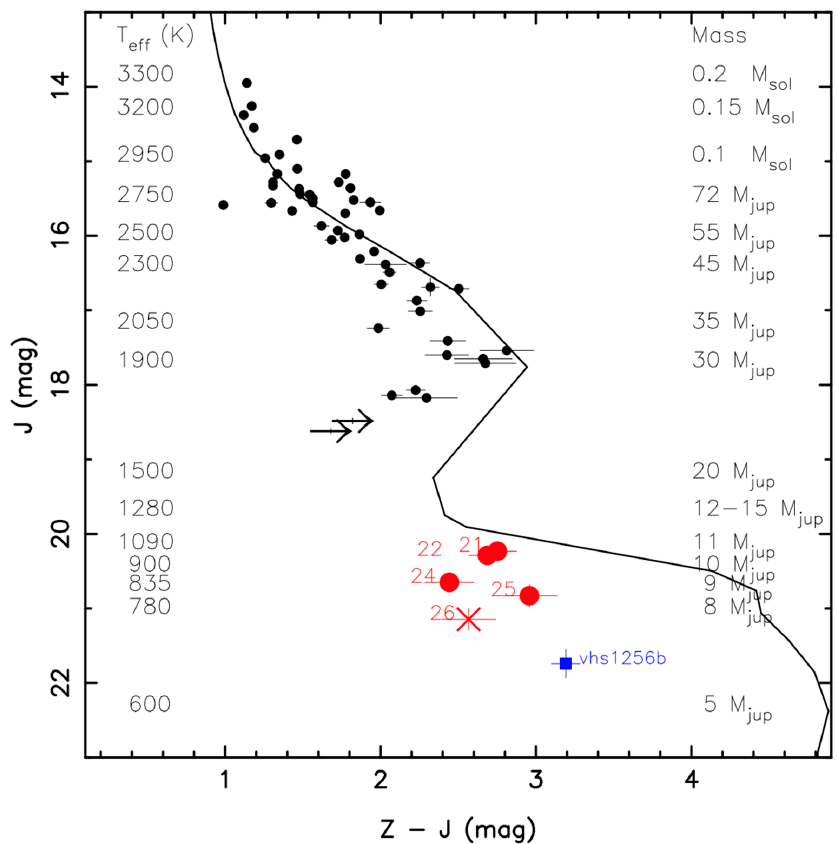
Figure 9. Optical/near-infrared color–magnitude diagram of Pleiades low-mass star, brown dwarf, and planetary-mass candidates from [166,168] (black dots) and [170] (red filled circles; see legend). Red asterisk: likely non-member Calar 26. Black arrows: color from Z-band upper limits. Solid line: 120 Ma isochrone [40]. Columns: theoretical effective temperatures and masses (in M Jup ) for this isochrone. Blue square: VHS J1256-911257 b [246] shifted to the Pleiades distance. Compare with Figure 7. Reproduced with permission from [170].